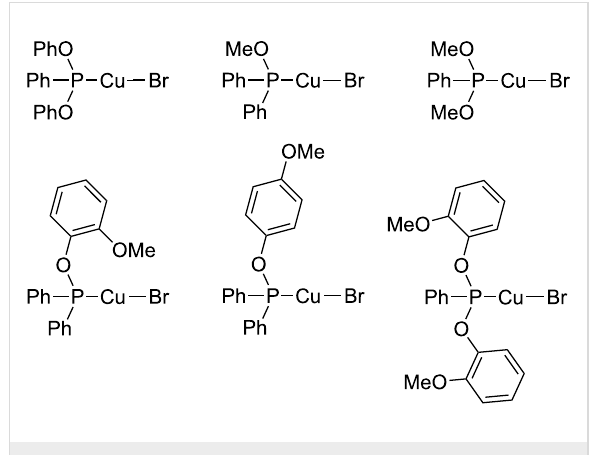
Figure 3: Phosphinite and phosphonite copper(I) complexes presented by Díez-González [144].